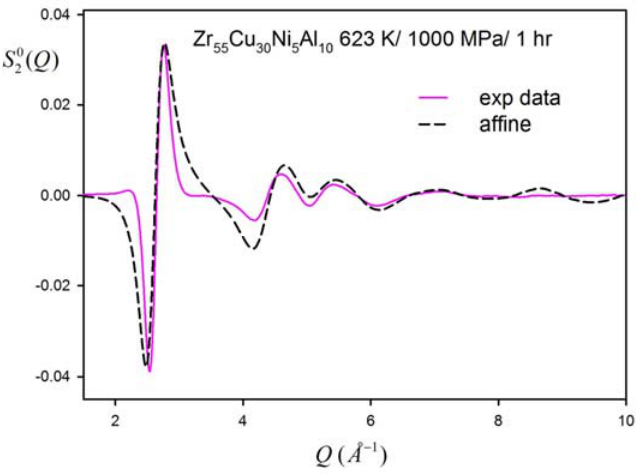
Figure 3. Anisotropic structure function S 2 0 ( Q ) . Line in pink shows 0